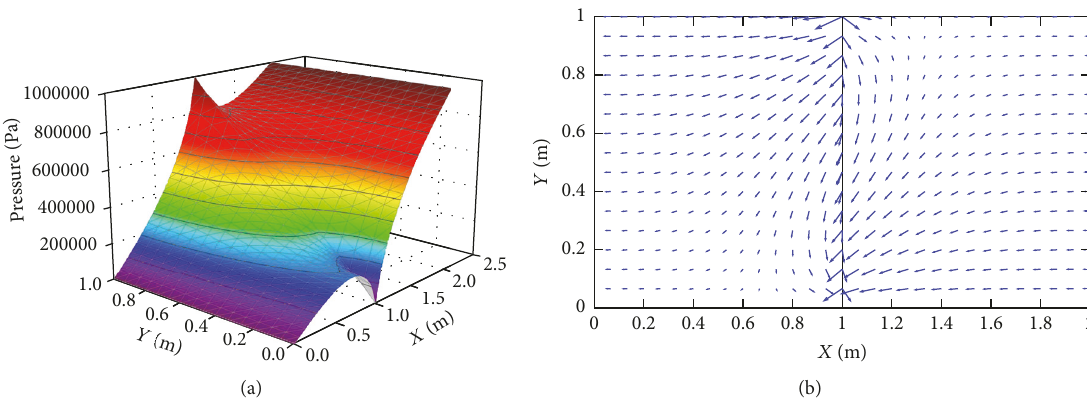
Figure 14: (a) The 3D pore pressure field and (b) velocity for the Forchheimer flow case.